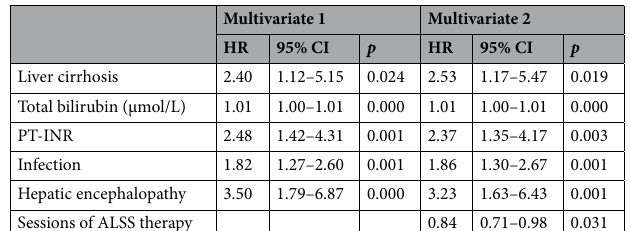
Table 3. Testing predictors for 3-month prognosis in validation cohort. HR hazard ratio, CI Confidence interval, PT-INR international normalized ratio (INR) of prothrombin time (PT), ALSS artificial liver support